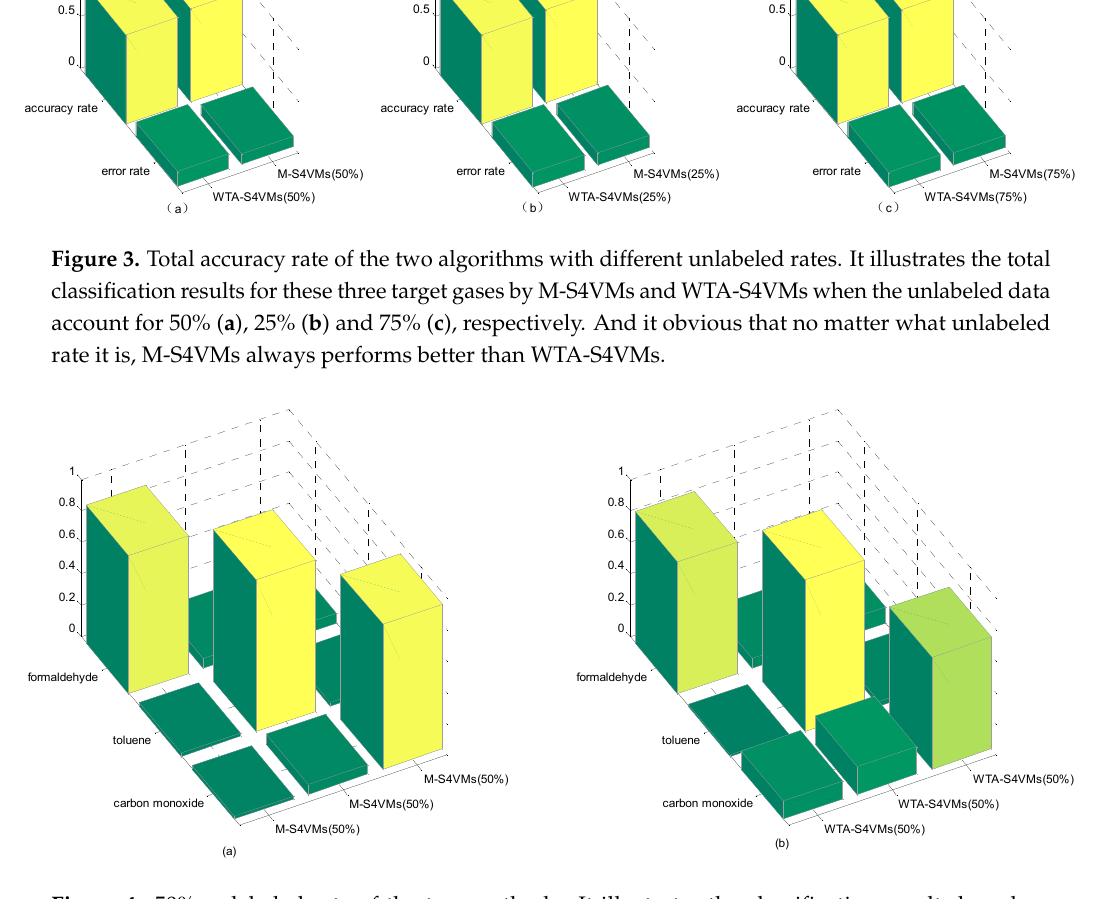
Figure 4. 50% unlabeled rate of the two methods. It illustrates the classification results based on three target gases by M-S4VMs ( a ) and WTA-S4VMs ( b ) when the unlabeled data account for 50%. It is obvious that M-S4VMs performs better than WTA-S4VMs especially in the classification of carbon monoxide.